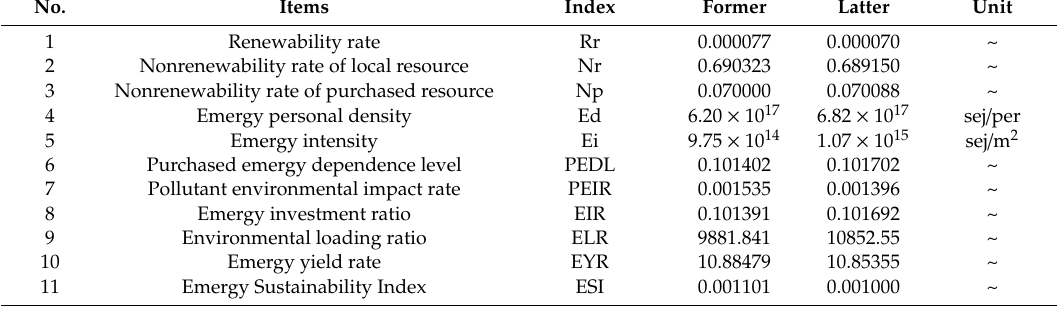
Table 14. The indicators changes between former and latter.